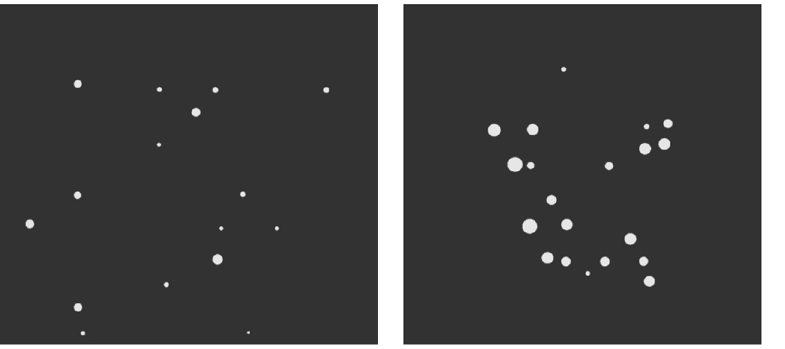
Figure 1. Item of the non-symbolic comparison task. The left group of dots has 16 dots. The right group of dots has 20 dots. The convex hull of the right group of dots is incongruent with the number of dots, but congruent with regard to the size of the